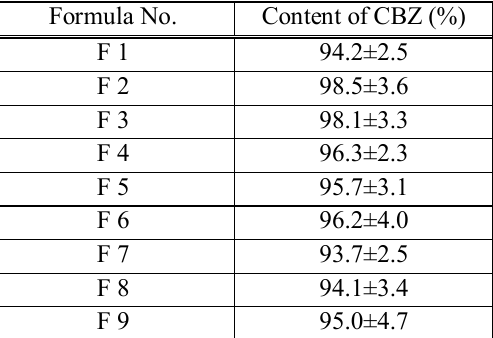
Table 4: Uniformity of dosage units for CBZ tablet (expressed as mean± standard) deviation.